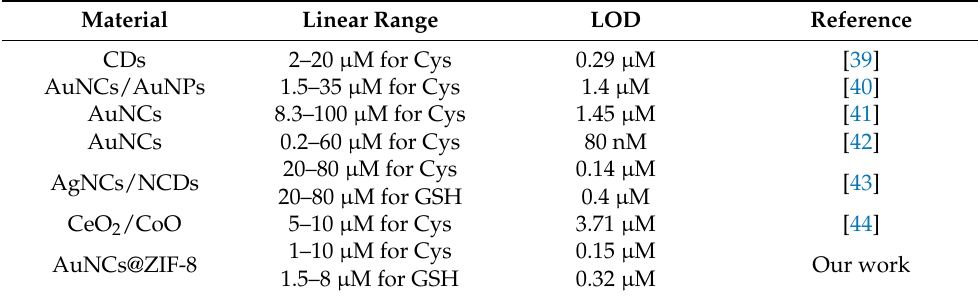
Figure 5. Relationship of fluorescence change of AuNCs@ZIF-8 and concentration of ( A ) GSH and ( B ) Cys molecules. Table 1. Comparison of different fluorescent probes for detection of biothiols.